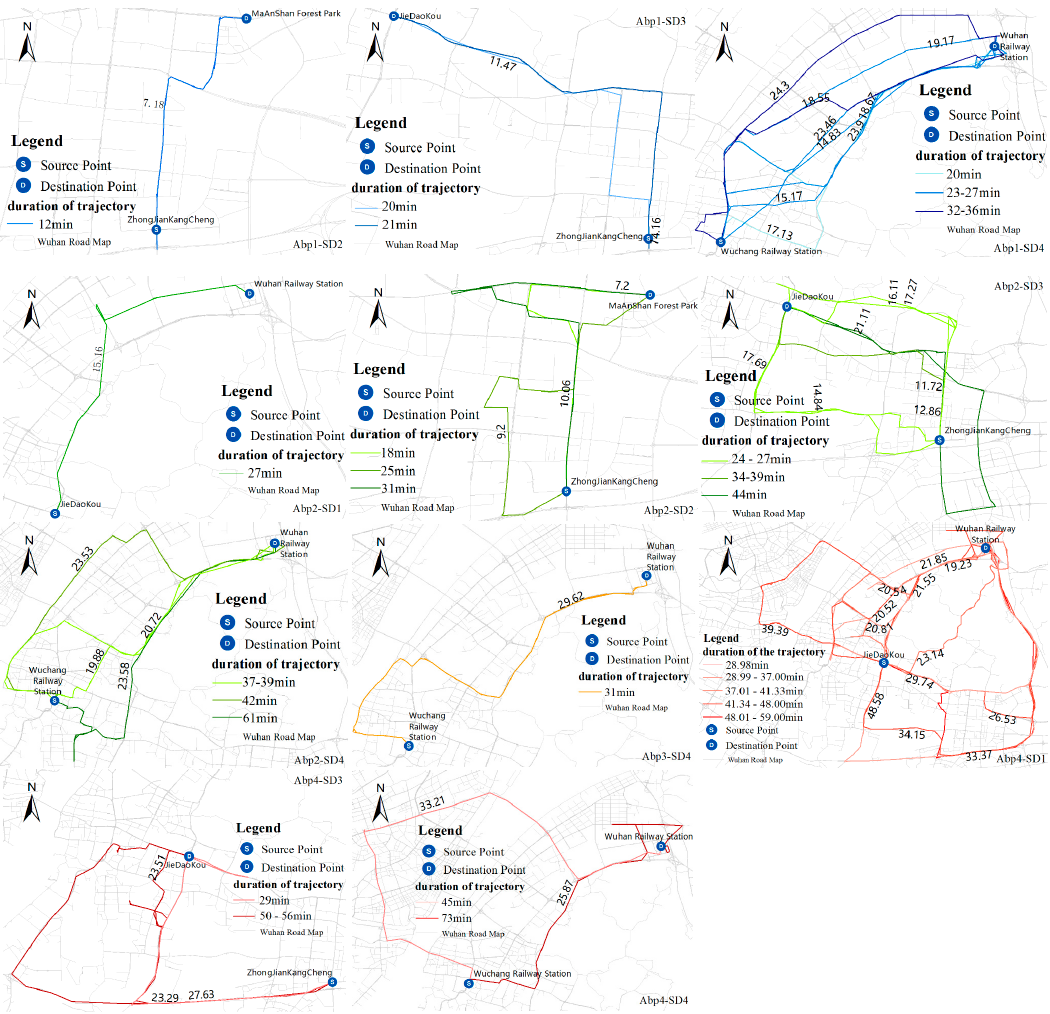
Figure 9. Geographic distribution of behavior patterns in the four pairs of experimental data.